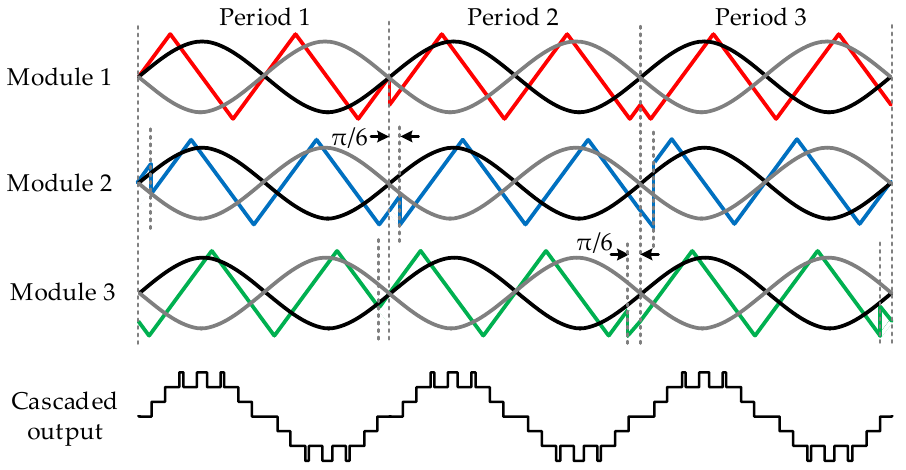
Figure 10. CPRS ‐ PWM scheme with asynchronous rotation time at reference zero ‐ crossing point. Figure 10. CPRS-PWM scheme with asynchronous rotation time at reference zero-crossing point. Energies 2020 , 13 , 1052